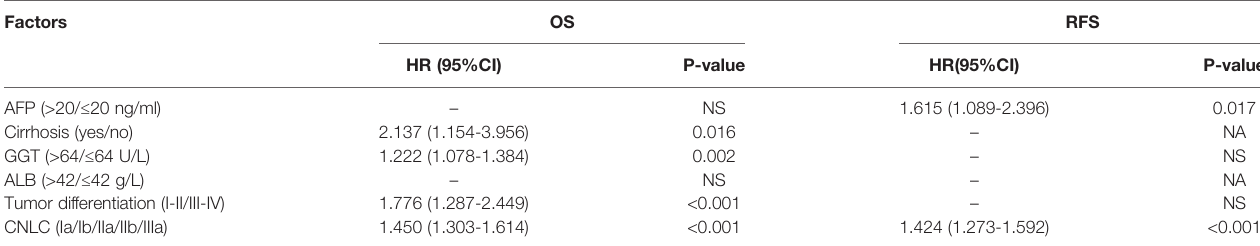
TABLE 2 | Multivariate Analysis of OS and RFS of HCC in primary cohort. Factors